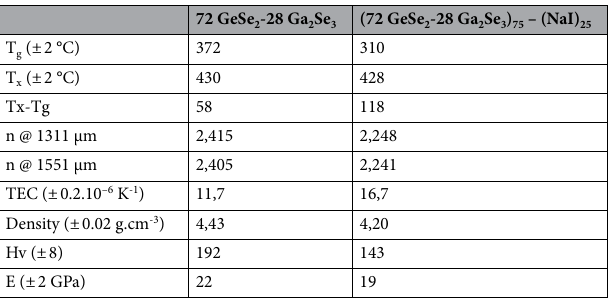
Table 1. Main Physical and optical characteristics of the studied glasses.